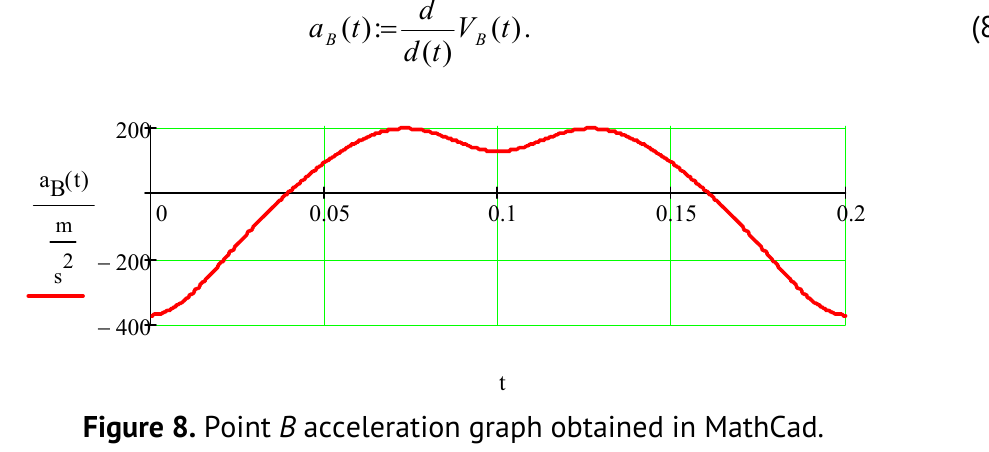
Figure 8. Point B acceleration graph obtained in MathCad.